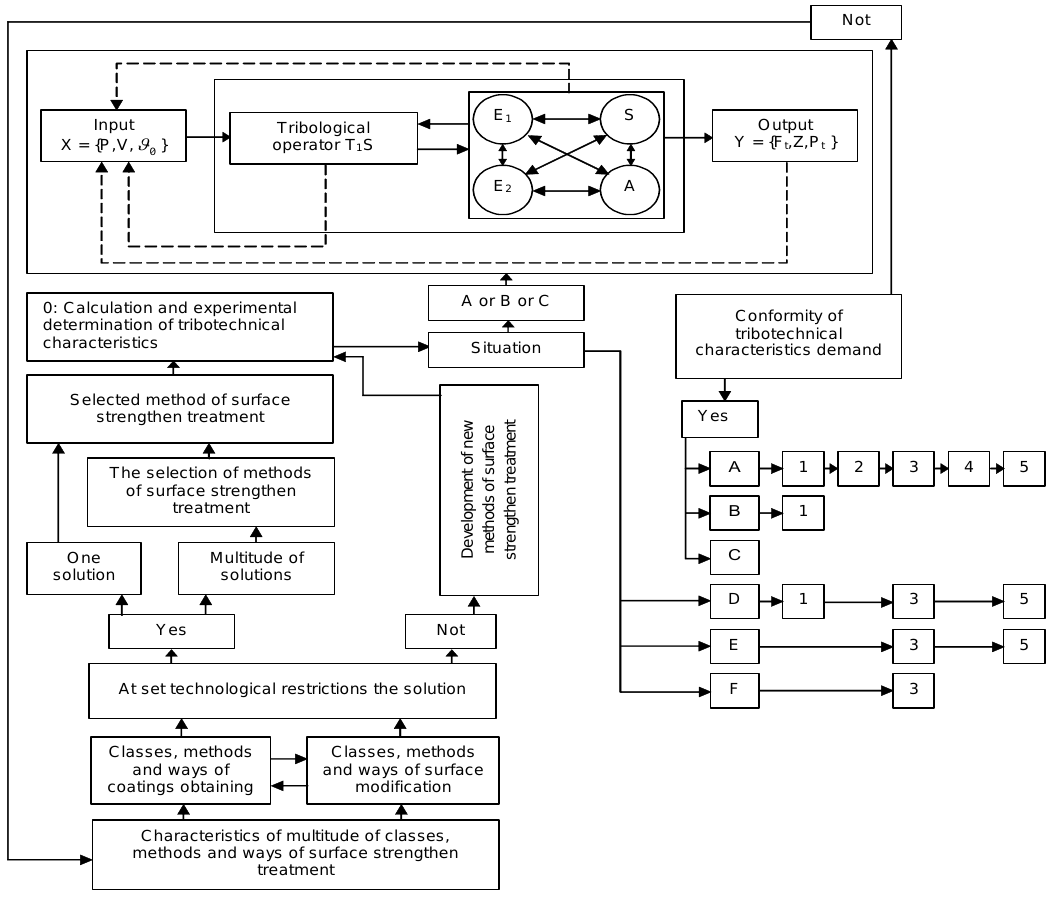
Fig. 2. Scheme of selection of optimal methods of surface strengthens